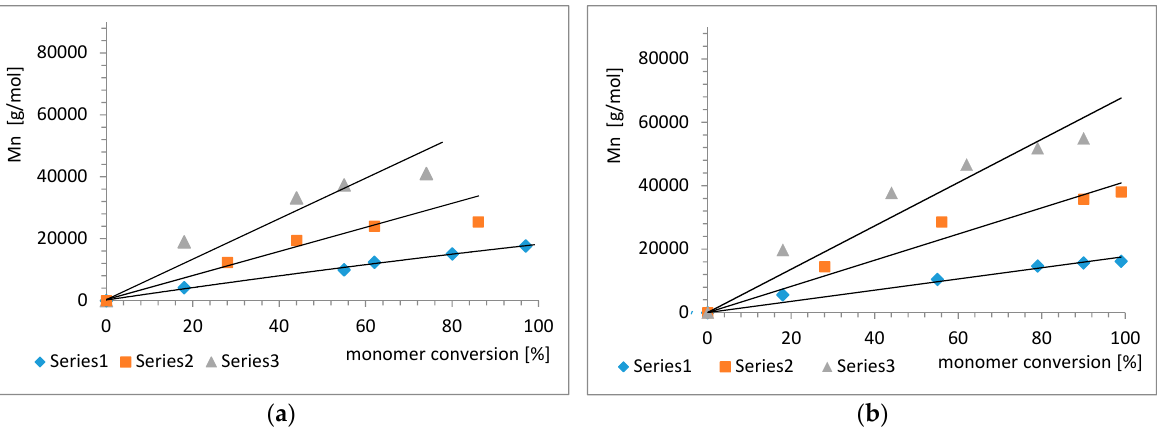
Figure 8. Relationship between the average molecular weight of the polylactide and monomer conversion; polymerization was conducted in bulk at 120 °C, initiated by Zn[(LPhe)(acac)H 2 O] ( a ), and Zn[(acac)(LTrp)H 2 O] ( b ). Series 1—with an M/I ratio of 150:1; Series 2—with an M/I ratio of 400:1; and Series 3—with an M/I ratio of 600:1.